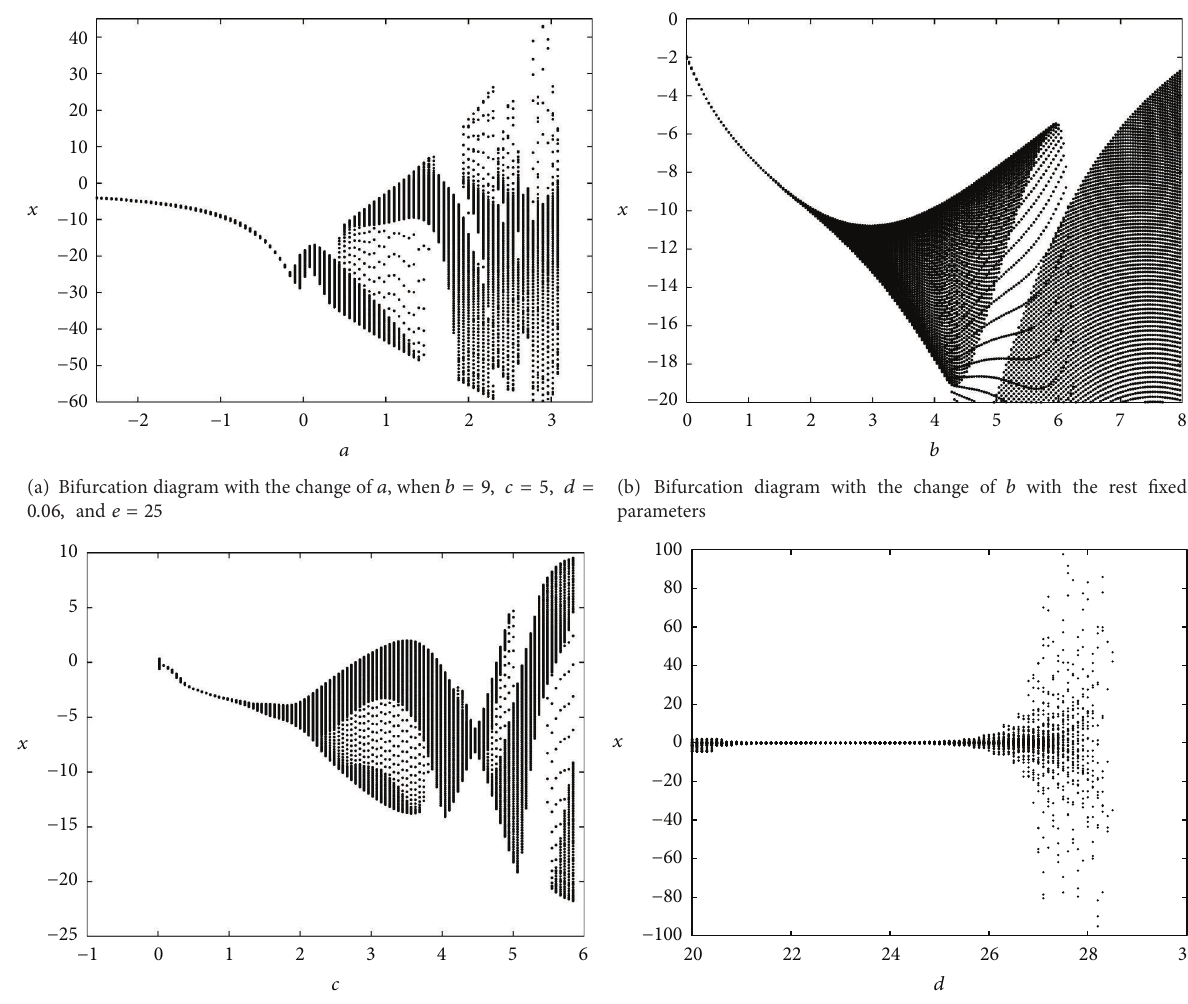
(d) Bifurcationdiagramwiththechangeof 𝑑 withtherestfixedparameters